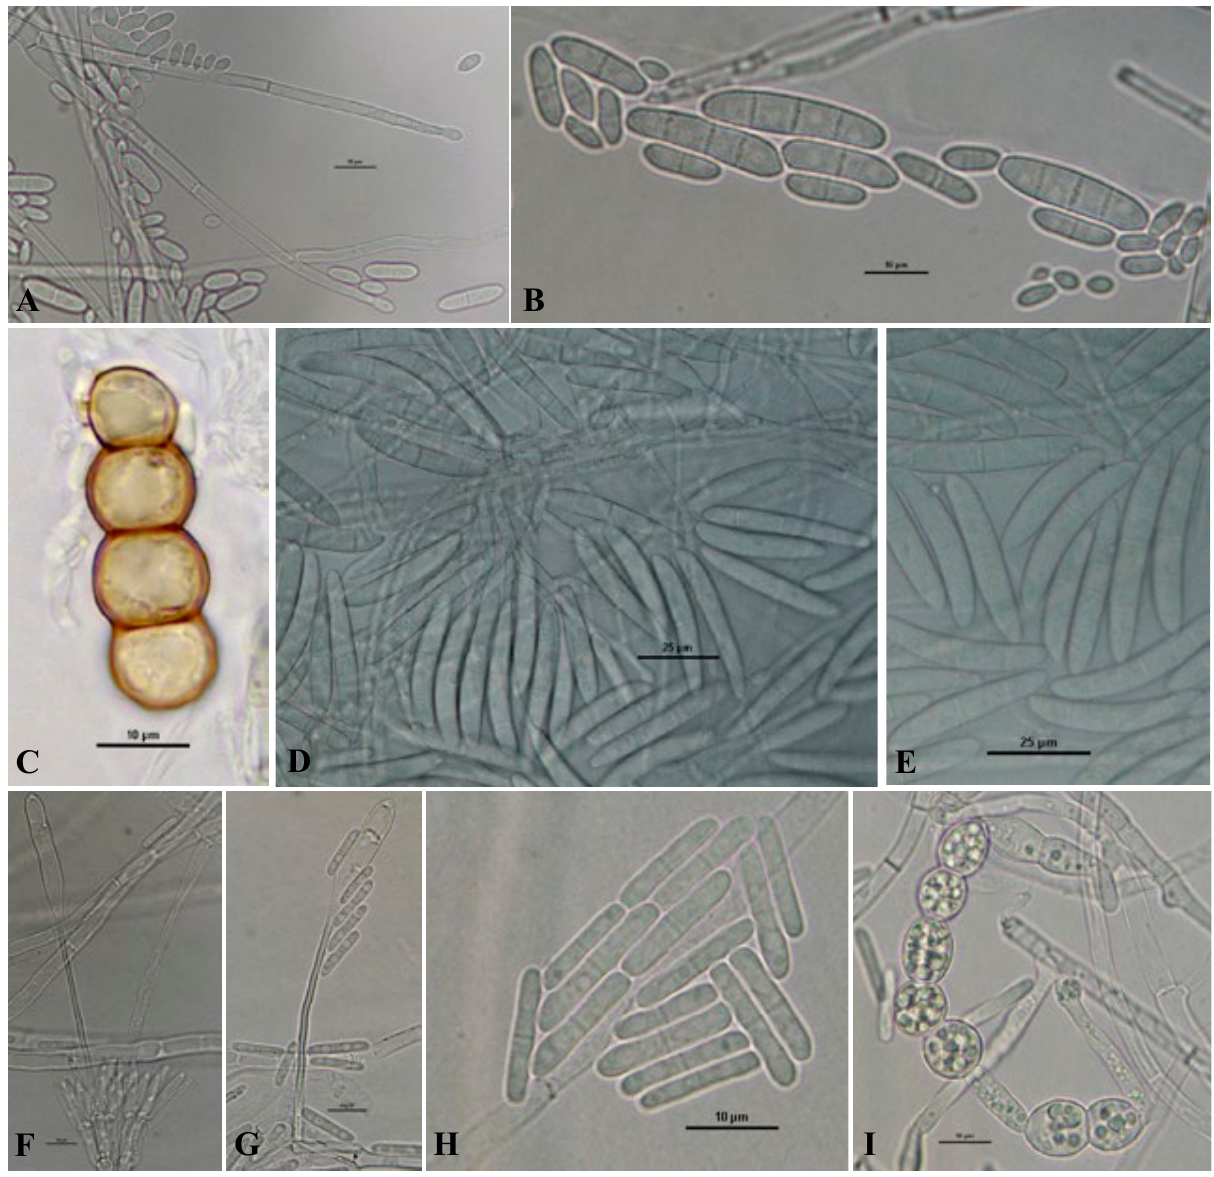
Figure 2. A, Conidiophores of I. liriodendri ; B, Macro- and microconidia of Ilyonectria liriodendri ; C, Chlamydospores in chains of “ Cylindrocarpon ” pauciseptatum ; D, Conidiophores of Campyl. fasciculare ; E, Macroconidia of Campylocarpon fas- ciculare ; F, Penicillate conidiophores of Cylindrocladiella parva ; G, Terminal vesicles of Cyl. parva ; H, Conidia of Cyl. parva ; H, Chlamydospores in chains of Cyl. parva . Scale bars: a‒c, f‒i = 10 μm; d‒e = 25